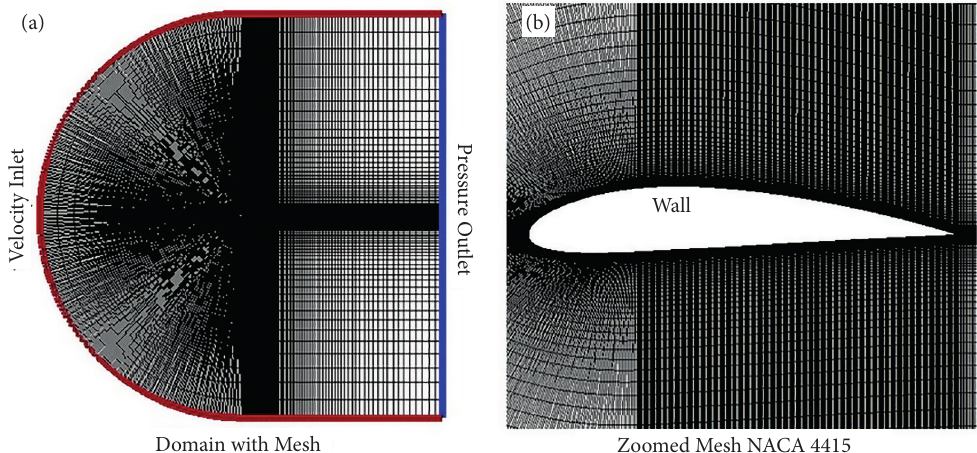
Figure 3. Domain used for simulation and mesh